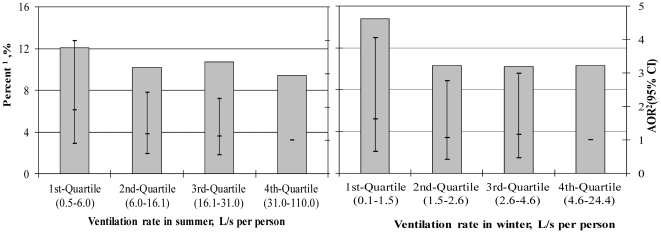
Associations between ventilation rate and common cold annual incidence ≥6 times.
1 Proportion of occupants with ≥6 common colds in the previous 12 months. 2 Odds ratios were adjusted for gender, age, family member allergy history, exposure to environmental tobacco smoke, building age and crowdedness. AOR: adjusted odds ratio; CI: confidence interval.